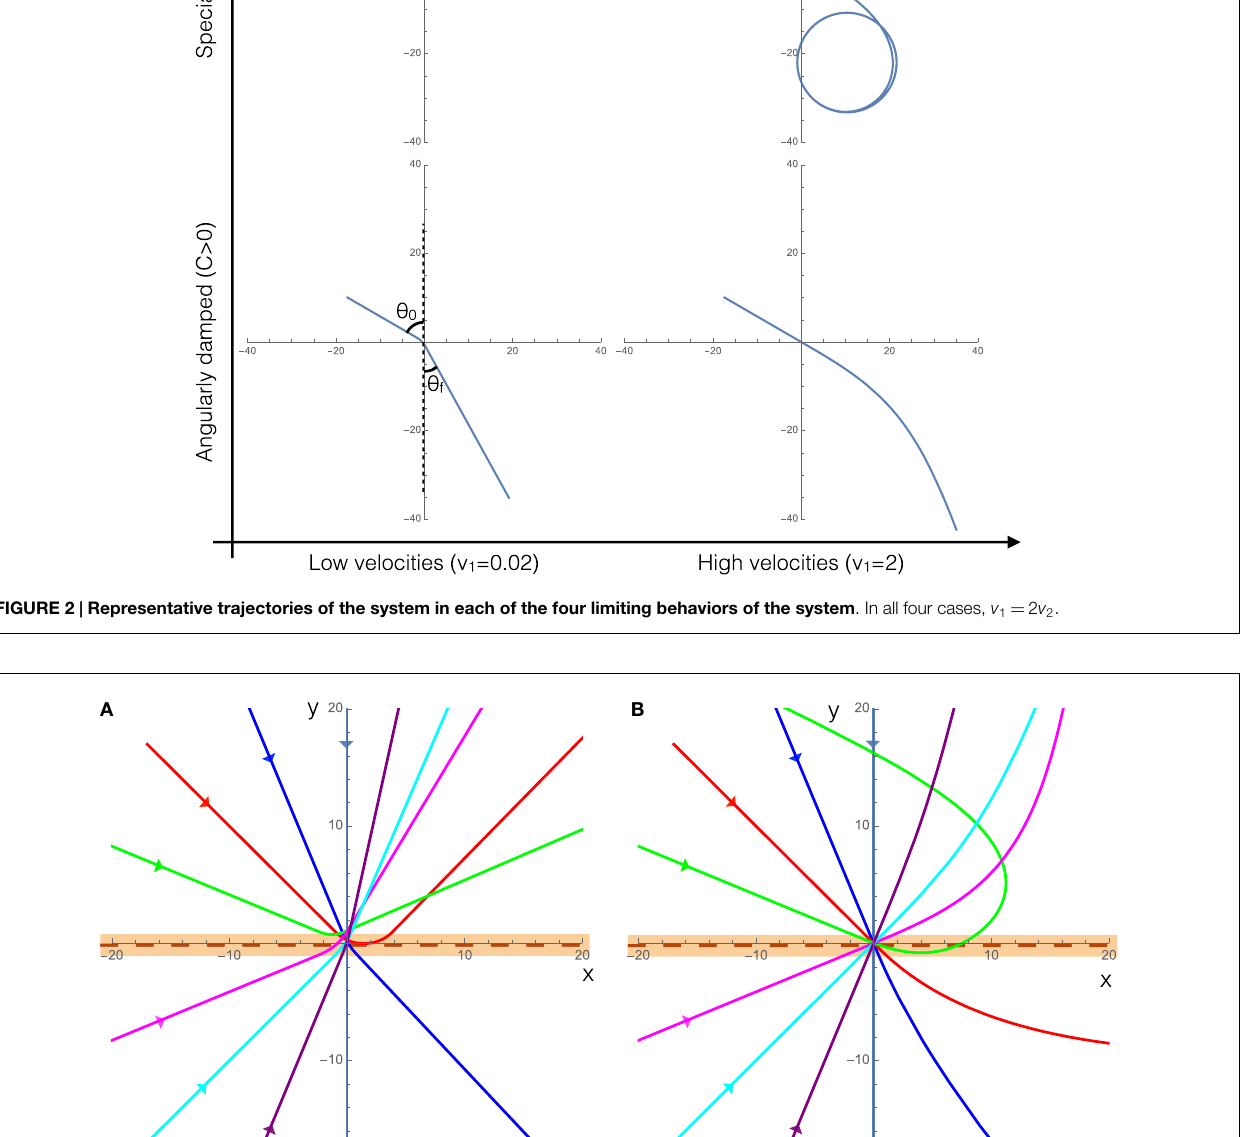
FIGURE 3 | Example trajectories of the cluster, each color is a different incident angle where the incoming cluster is shown by the straight lines entering from the left of each plot ( x < 0) directed toward the origin, and the clusters are in contact with the interface, which is at y = 0 (maroon dashed line), when the trajectory is within the orange band . The substrate on the bottom half ( y < 0) has twice the equilibrium speed as the top substrate ( v 2 = 2 v 1 ) in both cases. (A) For low speeds, where friction dominates cluster motion, the cluster curves while it is in contact with the interface (orange band), and once it leaves the interface it has a well defined straight path along some rotated polarization direction. (B) High velocities, when inertia dominates, result in the cluster starting to curve when it comes into contact with the interface and then large sweeping curves away from the interface as the momentum of the cluster causes it to persist along the previous direction before gradually adjusting to the new substrate.